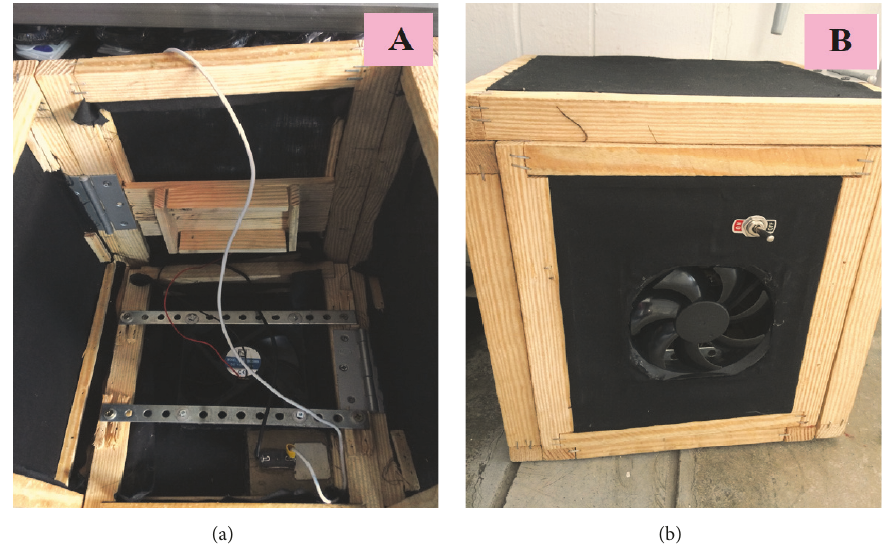
Figure 3: Design of the mosquito trapping box tested in Step 3 of the research and development phase. (a) Inside view; (b) outside